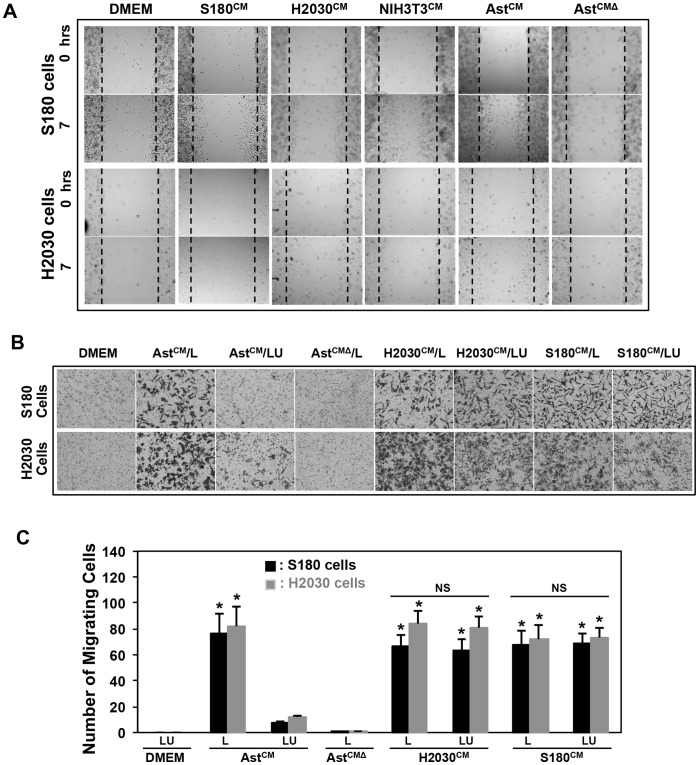
Effects of astrocyte secretome on tumor cell migration.(A) Representative images of S180 cell and H2030 cell migration. S 180 cells and H2030 cells were treated 8 h with different CMs from S180 cells, H2030 cells, NIH3T3 cells or astrocytes, respectively. (B) Representative images of S180 cell and H2030 cell transwell migration (Boyden chamber assay) for 5 h to examine the characteristics of astrocyte CM-induced tumor cell migration. (C) Quantitation of the number of migrated cells on the lower surface of the filter. L: lower chamber; LU: Lower chamber plus upper chamber. *p<0.01 compared with DMEM. For A and B, AstCM: astrocyte CM; AstCMΔ: astrocyte CM 120°C, 5–10 mins; H2030CM: H2030 cell CM; S180CM: S180 cell CM, NIH3T3 CM: NIH3T3 CM. Values are mean ± SD, n≥3.